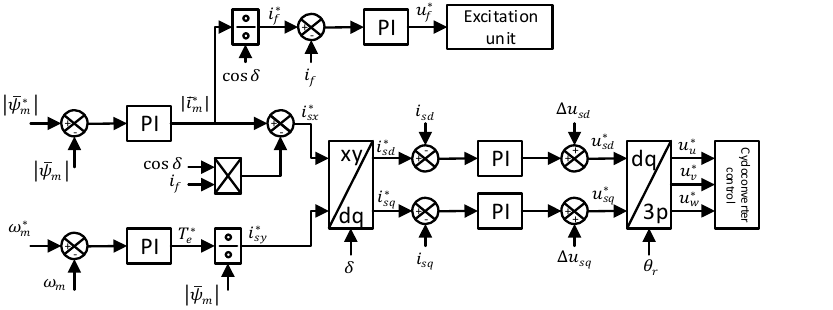
Figure 10. Control diagram of the magnetizing flux-oriented control for the electrically excited synchronous machine.